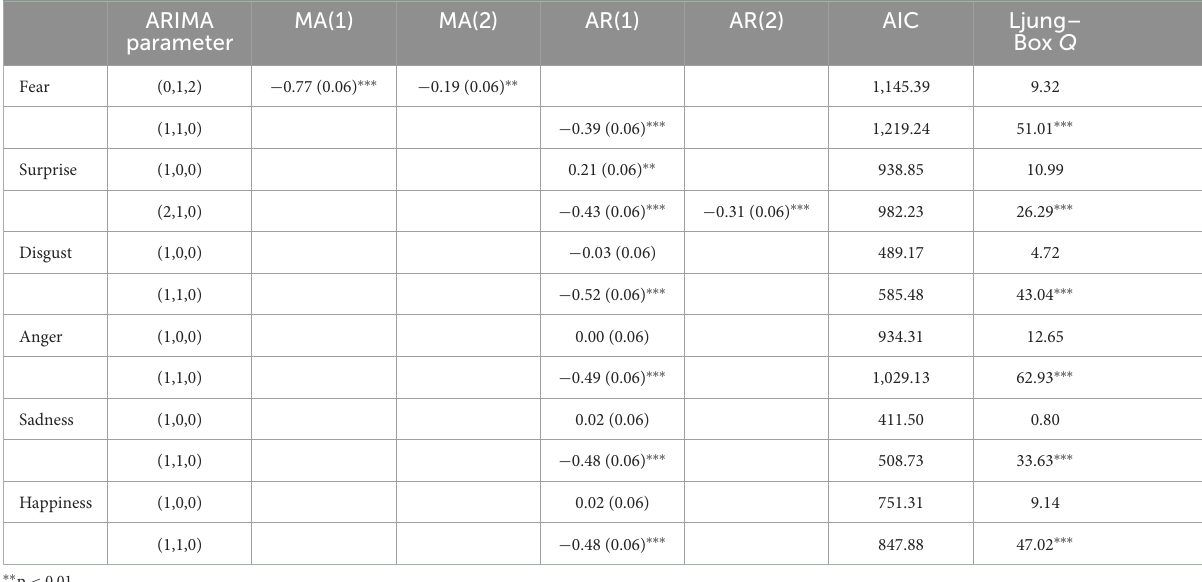
TABLE 2 ARIMA modeling results of the Lombarda China Healthcare Mix Fund. ARIMA parameter